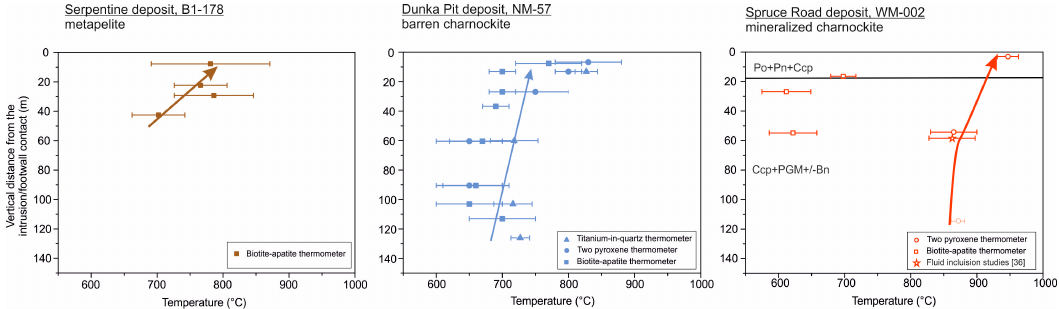
Figure 8. Variation of temperature in the footwall of the studied drill cores using titanium-in-quartz, two-pyroxene, and biotite-apatite thermometers. The top of the plots coincides with the intrusion-footwall contact.